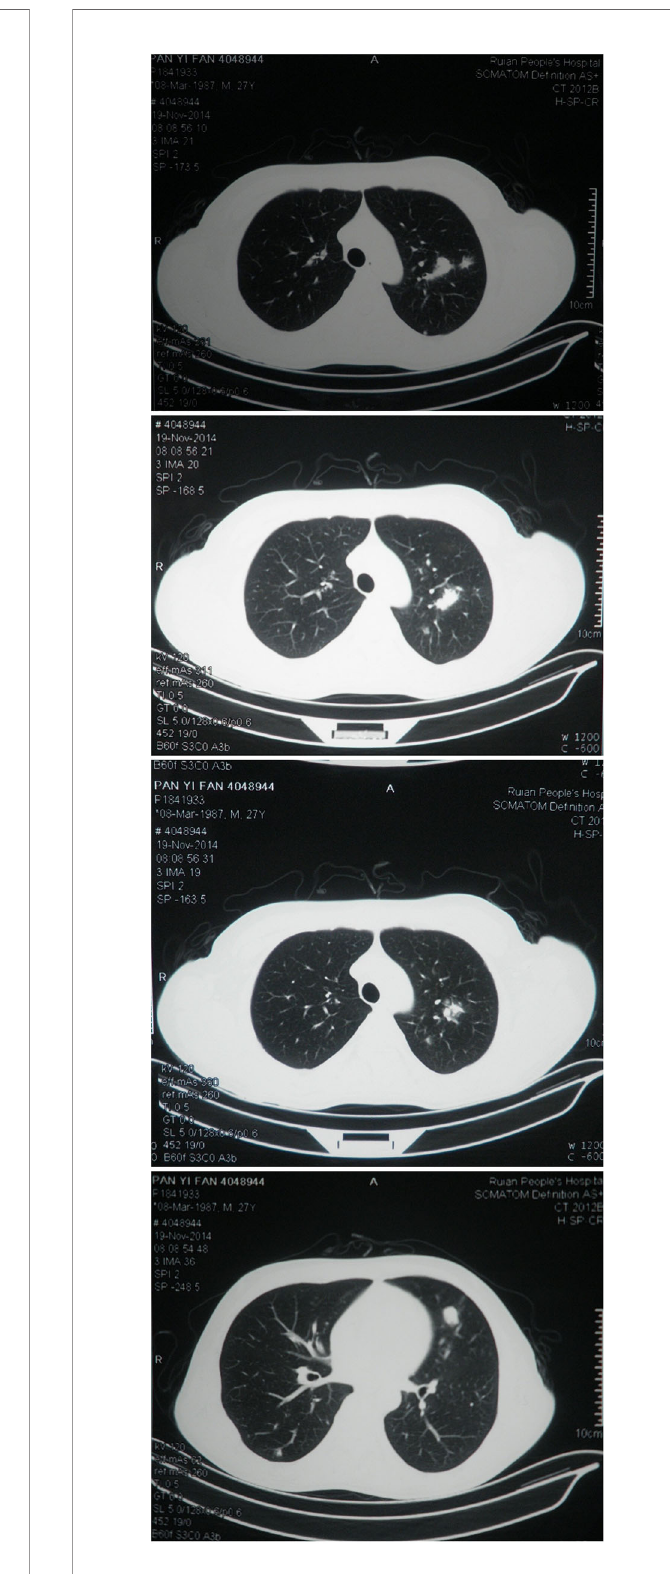
FIGURE 6 | Hematoxylin and eosin (HE) and immunohistochemical staining shows CD4+, CD5-, CD43+, MIB-1 40%+ LCA+.